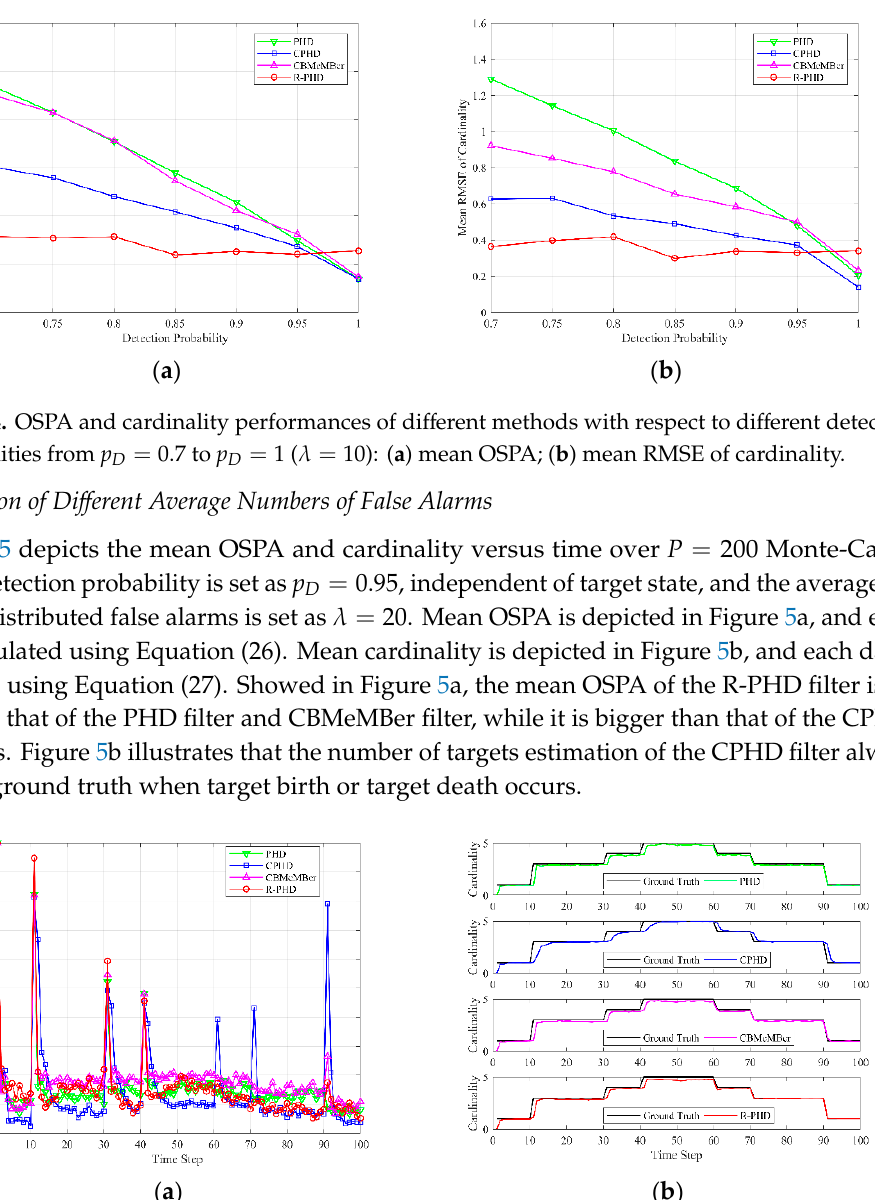
, 20 =λ ): ( a ) , 20 =λ ): ( a ) D p D p